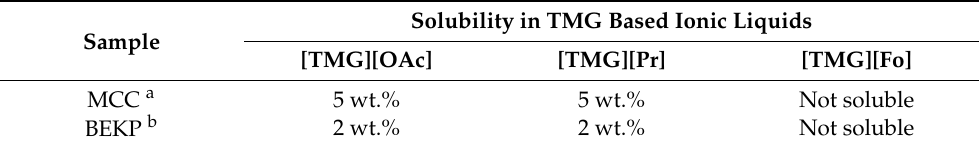
Table 1. Cellulose solubility in tetramethylguanidine (TMG) based ionic liquids at 90 ◦ C.